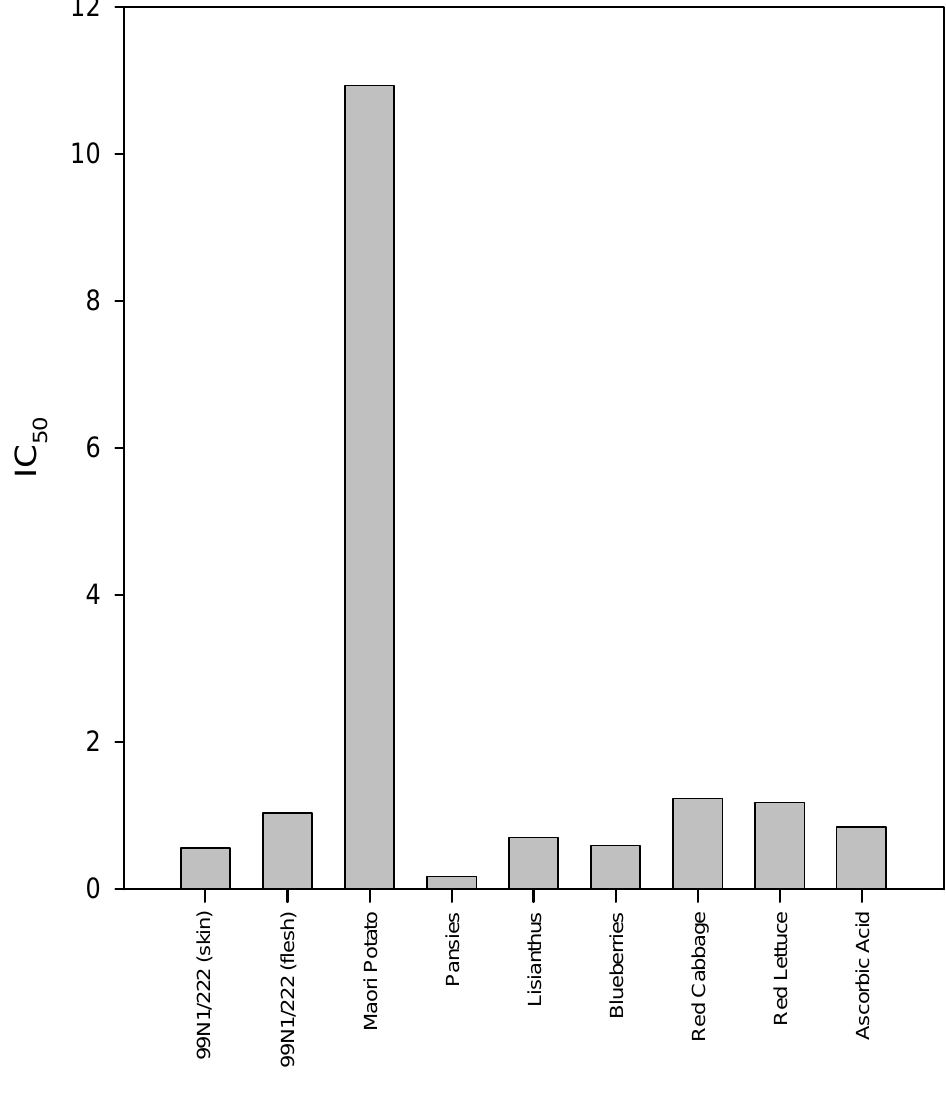
Figure 4 . Bar graph showing IC values for each anthocyanin extract from the TRAP 50 assay. The IC values represent the volume of extract required to reduce the absorbance of 50 the TRAP reaction mixture by half, and were calculated from the average of duplicate